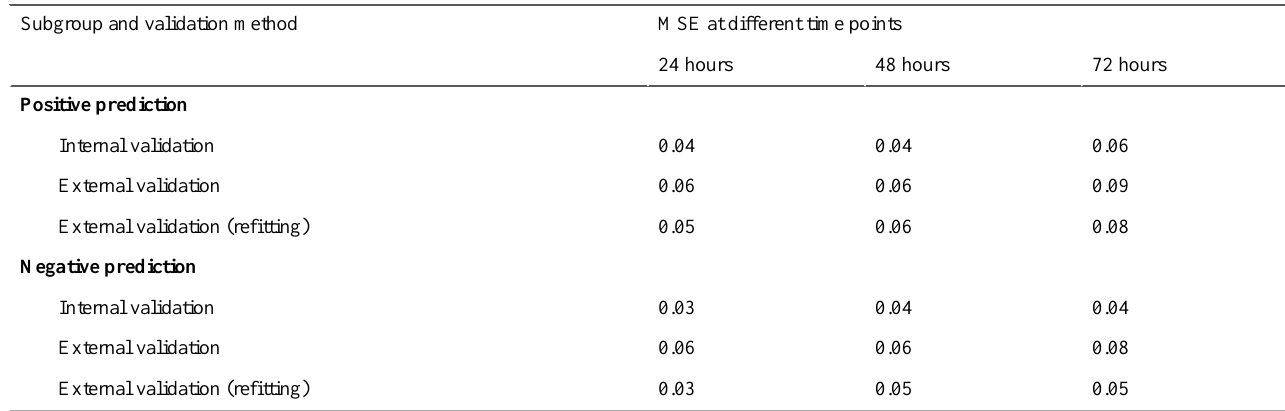
MSE at different time pointsSubgroup and validation